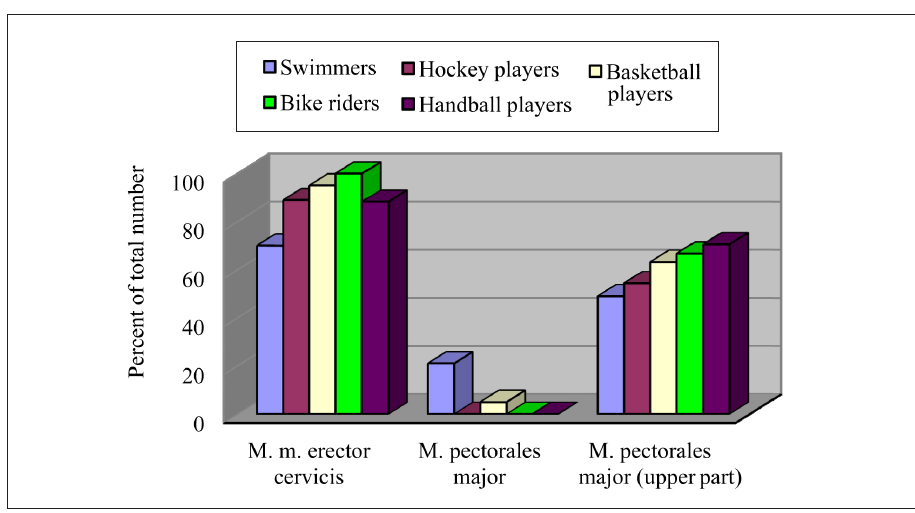
Figure 2. Results of swim- mer, ice-hockey,